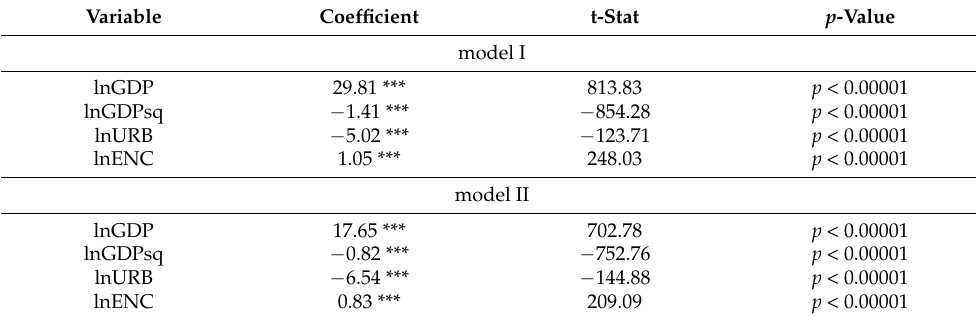
Table 7. Panel FMOLS test